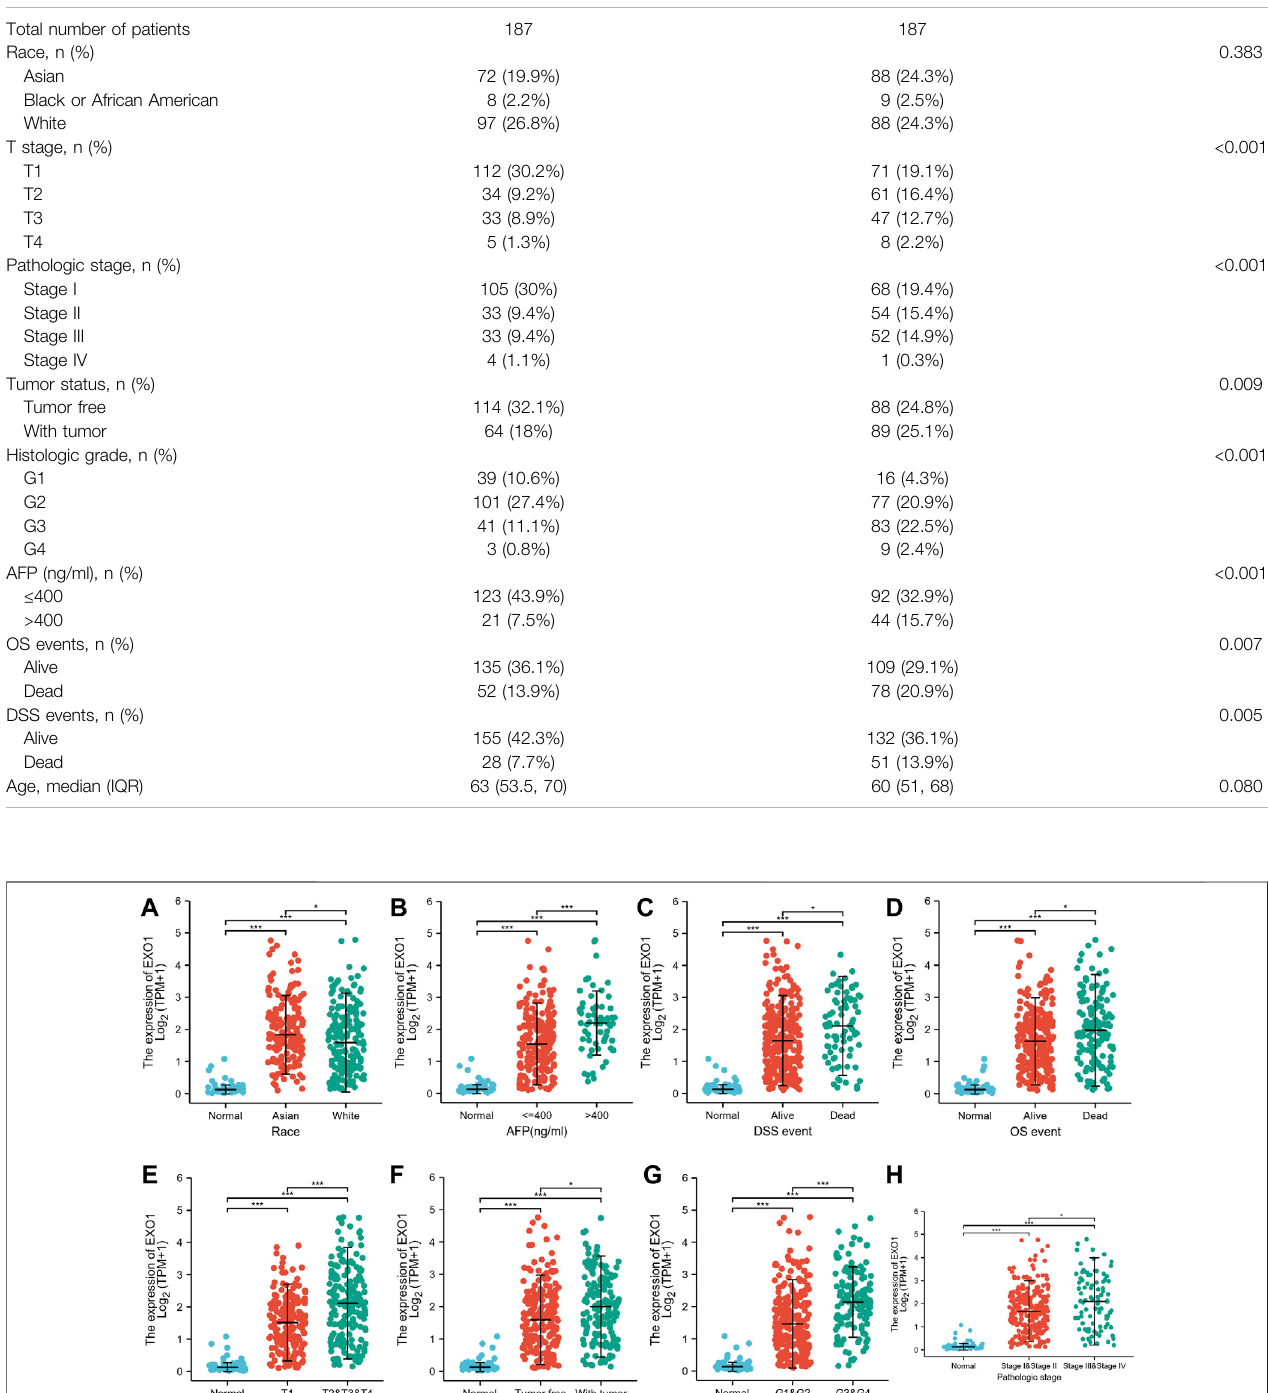
TABLE 2 | Clinicopathological characteristics of HCC patients with high- and low-EXO1 expression levels. Characteristic